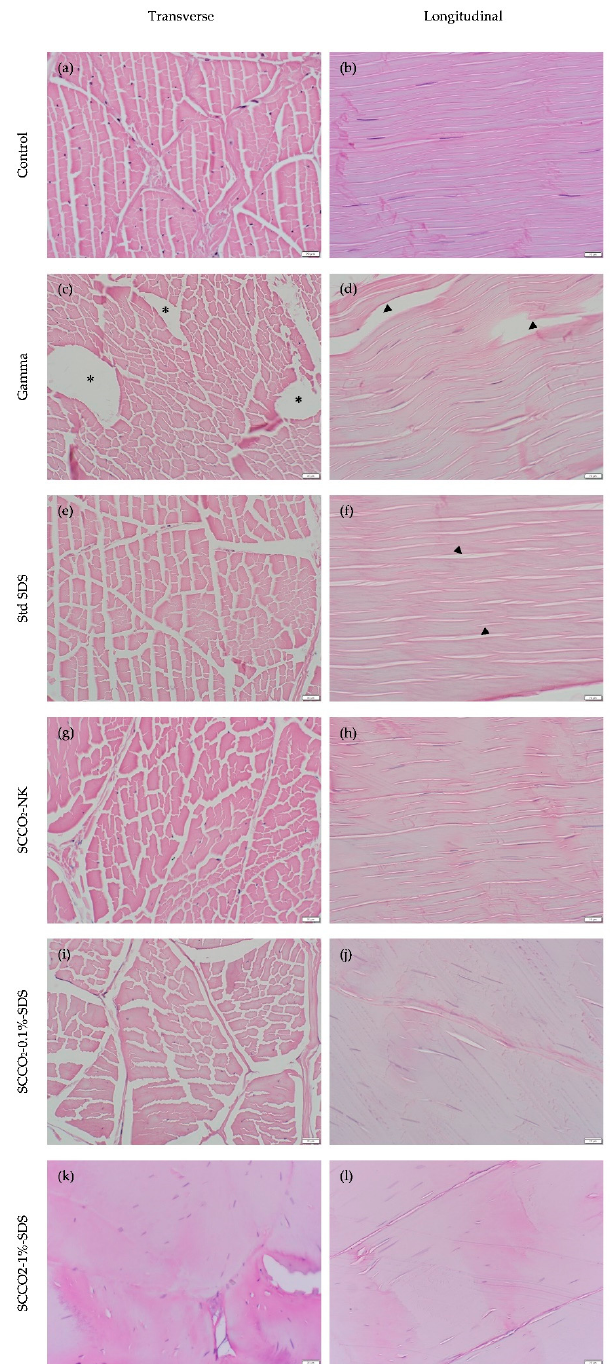
Figure 2. Representative high-resolution histological images of transverse and longitudinal sections. In haematoxylin and eosin (H&E) sections, collagen was stained pale pink with interspersed dark blue nuclei conspicuous in all groups except the standard SDS group. The histological dead space in the transverse sections are indicated with *. Separation of collagen bundles are indicated with black arrowheads. Scale bar at the bottom right represents 20 µ